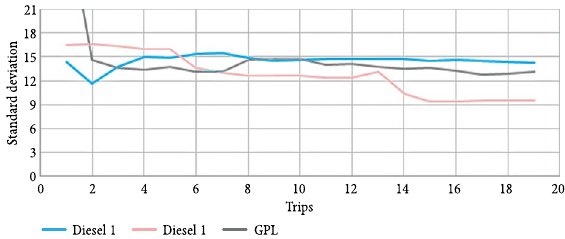
Fig. 2. Standard deviation trend of the percentage error